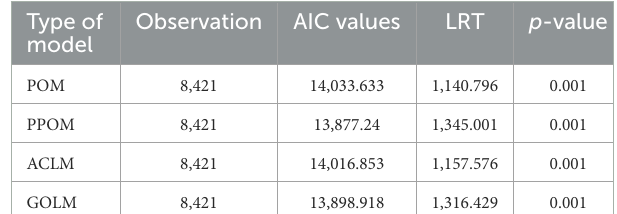
depicted that the neighboring zones are independent ( p -value > 0.05) for the three consecutive survey years.